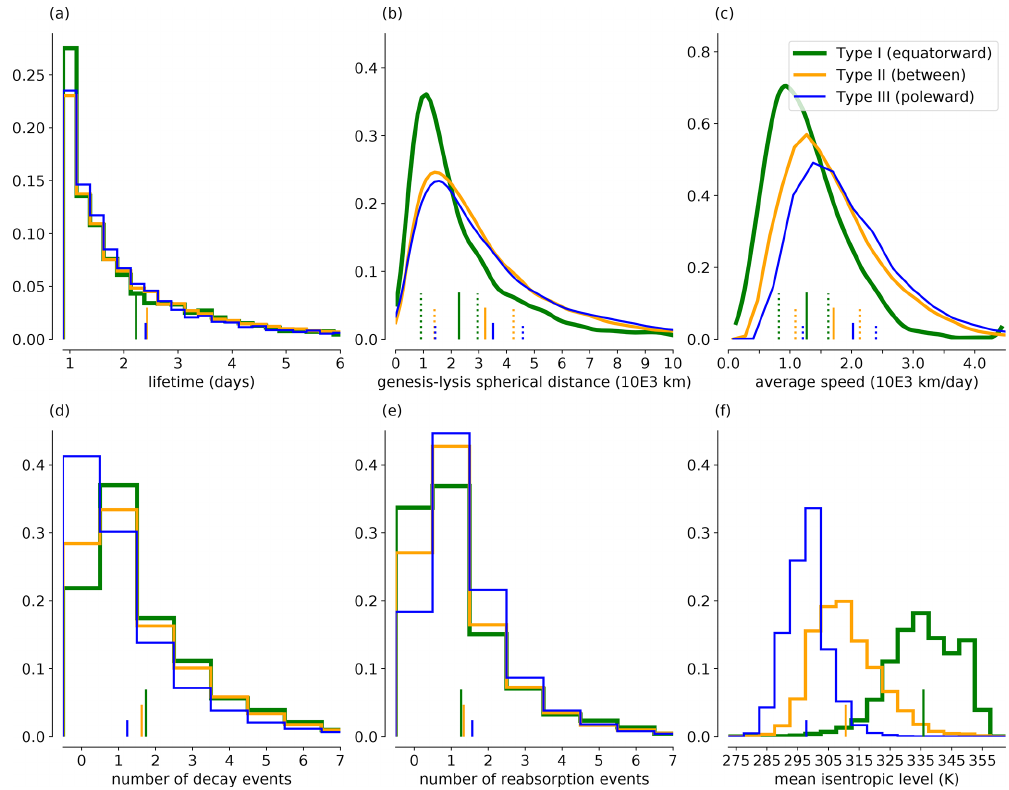
Figure 9. Empirical distributions of (a) lifetime, (b) spherical distance between genesis and lysis locations, (c) average propagation speed, (d) number of decay events, (e) number of reabsorption events, and (f) the mean isentropic level during the life cycle PV cutoffs of Types I, II, and III. (a, d, e, f) Distributions are shown as normalized histograms with the bar widths corresponding to unity; i.e., the vertical axis values can be read as percentages. (b, c) Distributions are shown as density estimates. Vertical lines indicate (solid) mean values and (dashed) upper and lower